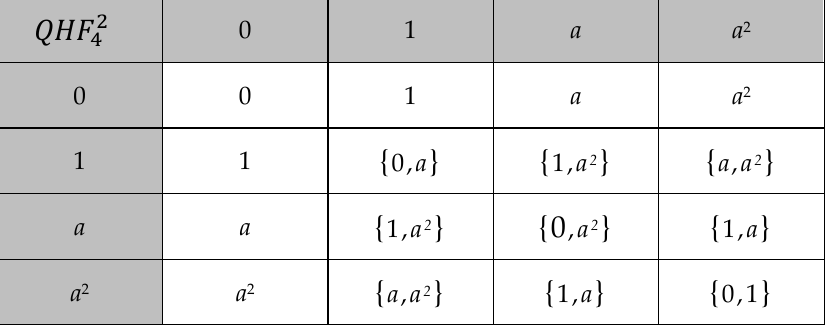
Table 7. The Cayley table of the additive canonical hypergroup of the quotient hyperfield ℤ 7 /{ 1,6 }.